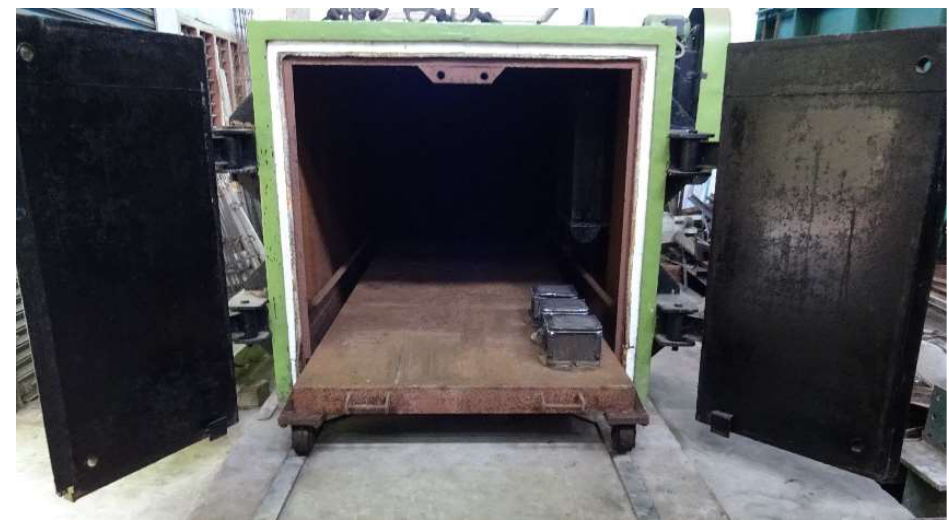
Figure 2. Specimens in the steam curing chamber.